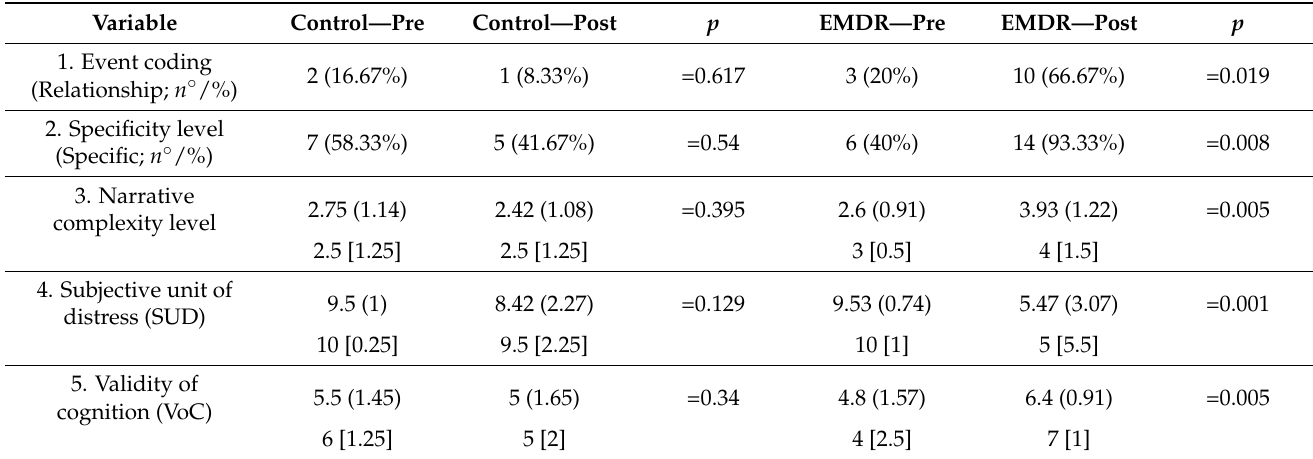
Table 2. Group comparisons among the study measures within EMDR ( n = 15) and control (12) samples assessed pre-intervention and